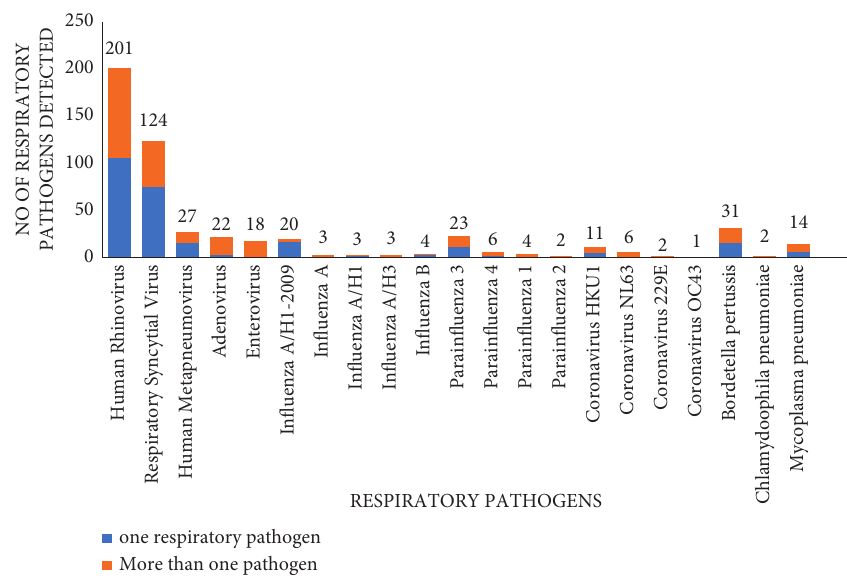
Figure 2: Distribution of respiratory pathogens in children.